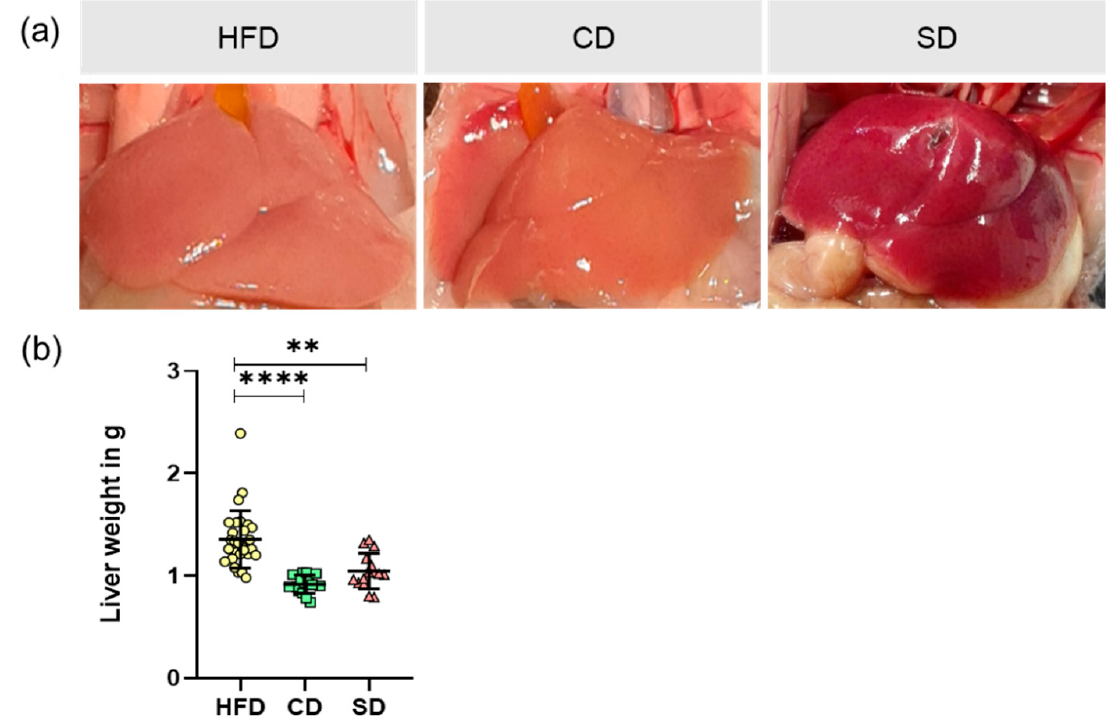
Figure 3. ( a ) Representative in situ images of mice livers from mice fed high fat diet (HFD), control diet (CD) or standard diet (SD); ( b ) Liver weight of the di ff erent groups (HFD: n = 29; CD: n = 15, SD: n = 15) presented as mean ± standard deviation. Significance of di ff erences between the groups was tested by one-way ANOVA on Ranks (Kruskal–Wallis); **** p < 0.0001, ** p < 0.01.